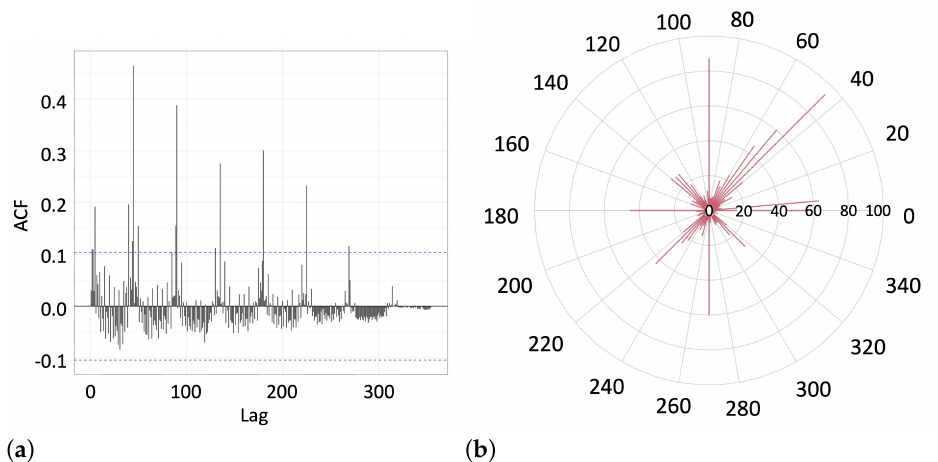
Figure 7. ( a ) The autocorrelation function (10) represents the statistical significance of lags between the sequential line angles in Group 3. The dashed horizontal lines indicate the level of statistically significant correlations. ( b ) The radial histogram (not normalized) of the line-drawing angles observed in Group